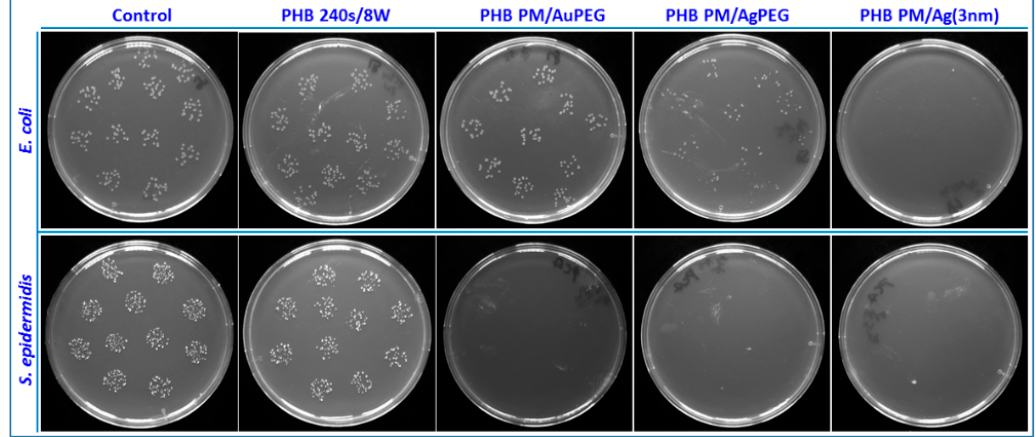
Figure 8. The photographs of E. coli and S. epidermidis colony forming units on the samples: control sample, plasma modified sample with the power of 8 W and time 240 s (PHB 240 s/8 W), and then plasma modified sample consequently: (i) immersed to Au/PEG/H 2 O solution (PHB PM/AuPEG); (ii) immersed to Ag/PEG/H 2 O solution (PHB PM/AgPEG) or sputtered with silver of the effective thickness of 3 nm determined by gravimetry (PHB PM/Ag, 3 nm) [121].